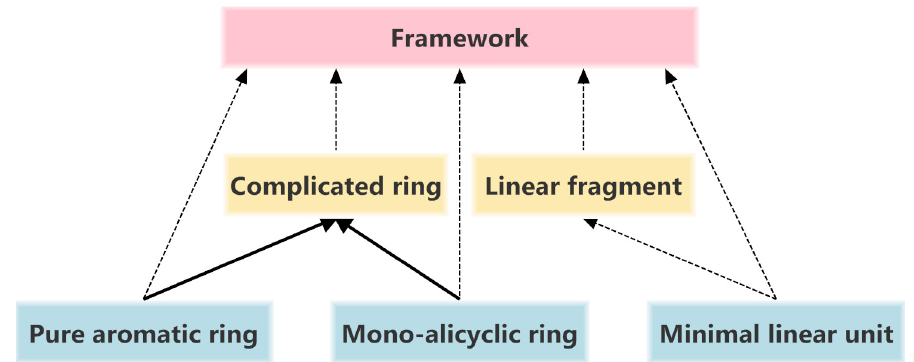
Figure 3. Relationships among the structural hierarchies of molecules with circular substructures. ( atom connection, bond fusion, top level, second level, third